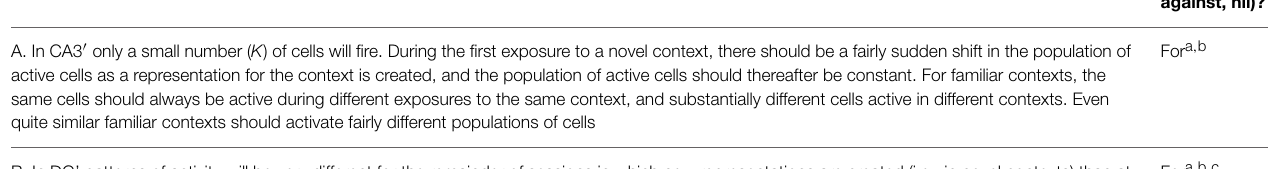
TABLE 3 | Some behavioral properties of BACON.